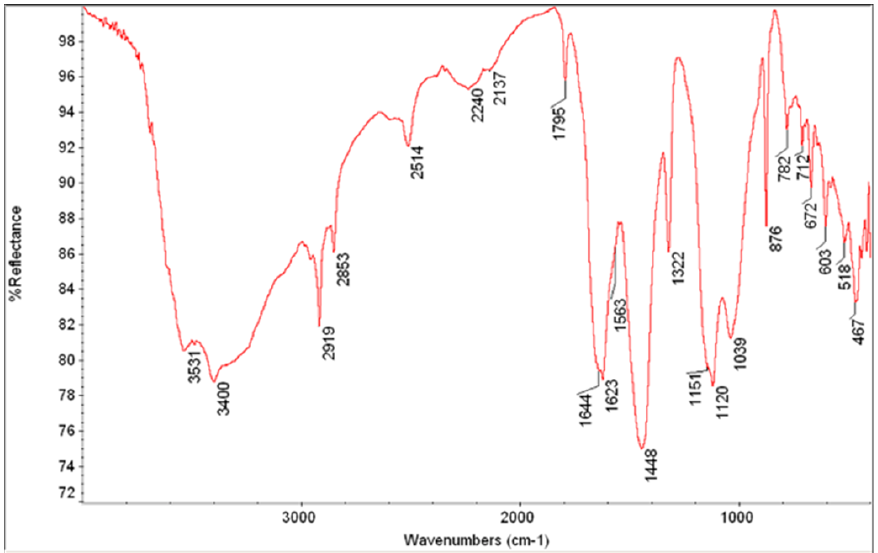
Figure 12. Spectrum of a sample taken from the upper frieze in correspondence with a brown surface layer.